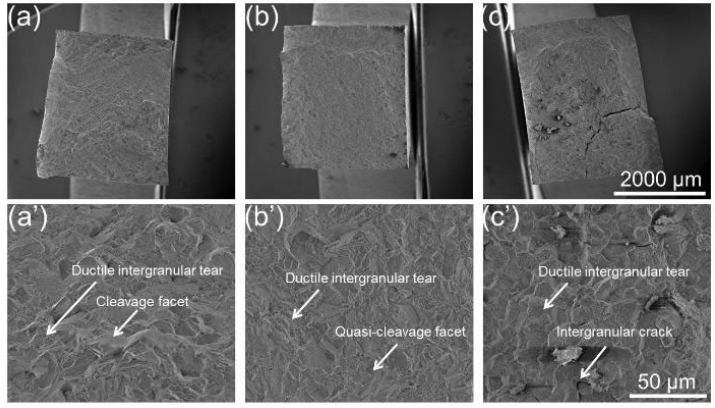
Figure 11. Fracture surfaces of SH at 550 °C ( a , a’ ), 750 °C ( b , b’ ), and 830 °C ( c , c’ ). The mean grain sizes of the undeformed and deformed samples were statistically measured by EBSD and are presented in Figure 12. The grain size of SH is influenced significantly by deformation and the deformation temperature compared to that of SL. The average grain size of the undeformed SH sample was measured to be 35.07 µ m, which was the lowest among the four SH samples. With an increase in the deformation temperature, the grain size became higher and reached 41.51 µ m after deformation at 830 ◦ C. Compared to SH, the average grain sizes for SL did not vary greatly through deformation.